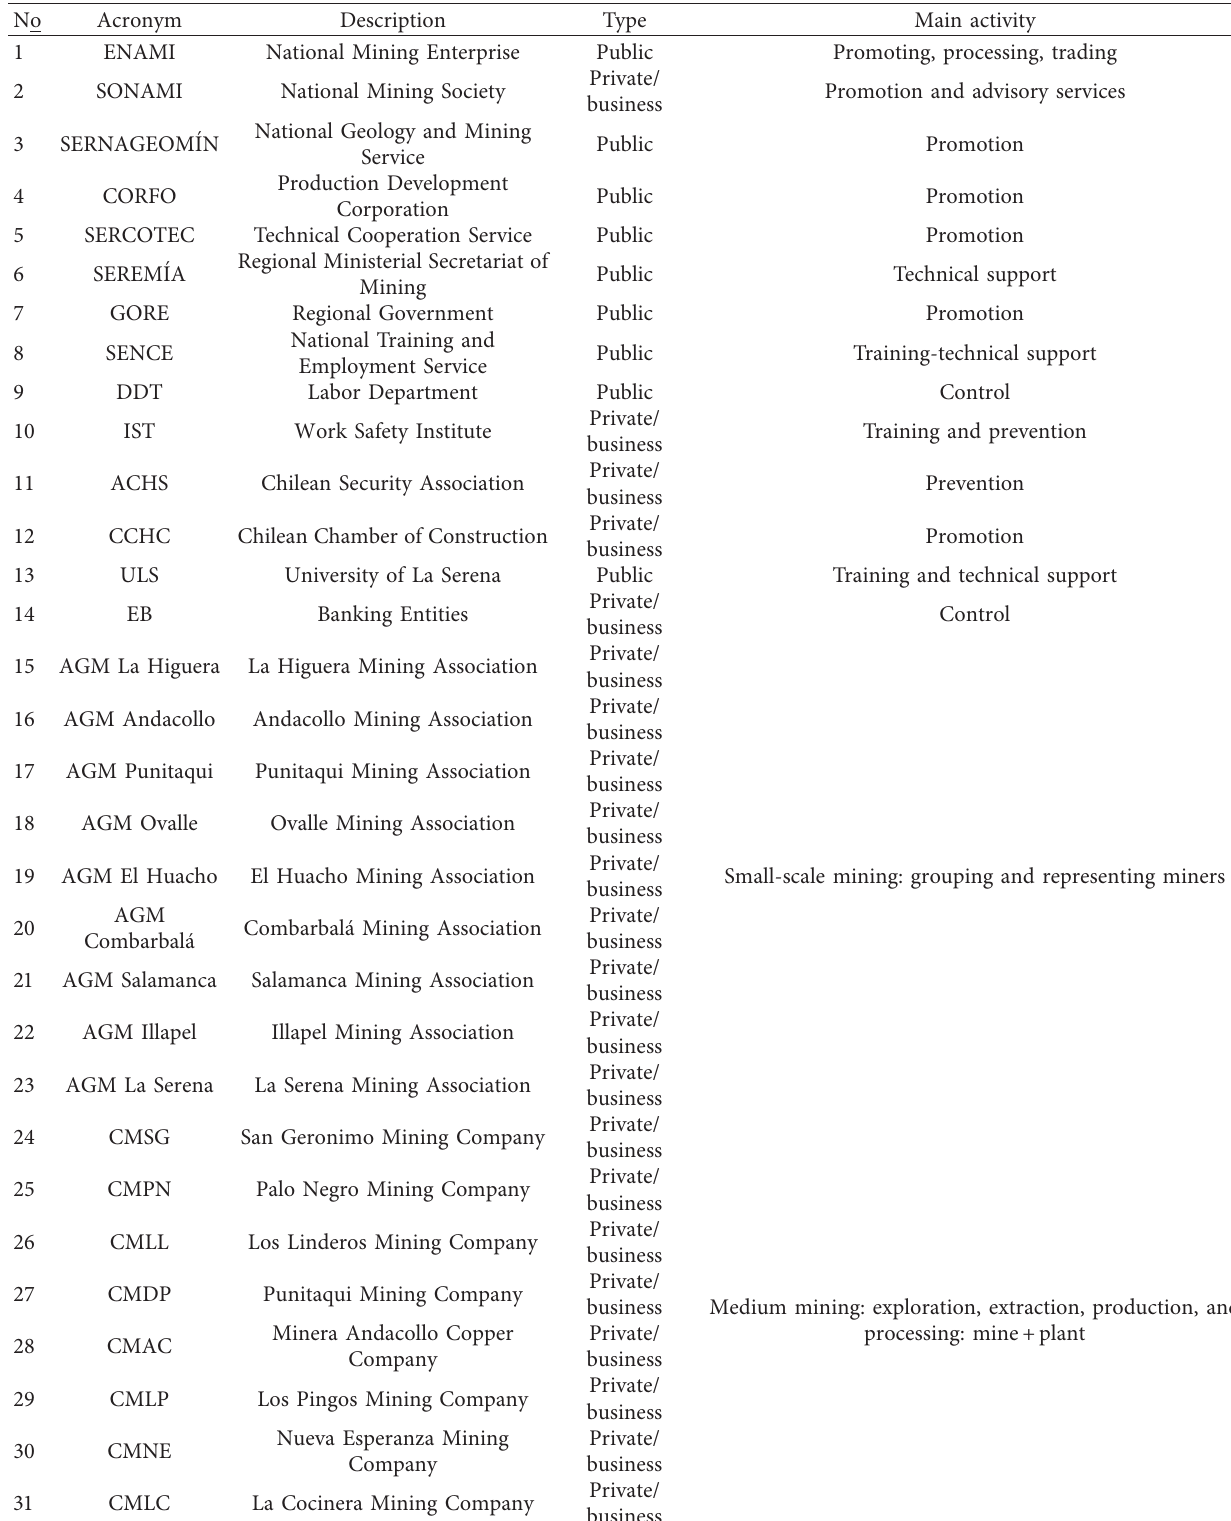
Table 2: List of